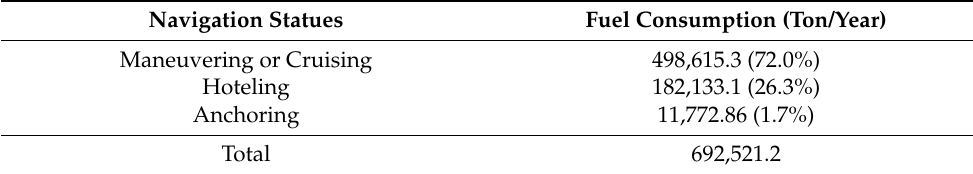
Table 8. Fuel consumption depending on navigation statues in BP in 2019.